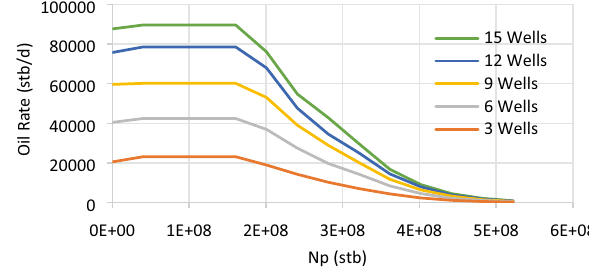
Fig. 1 Example of proxy model for oil production